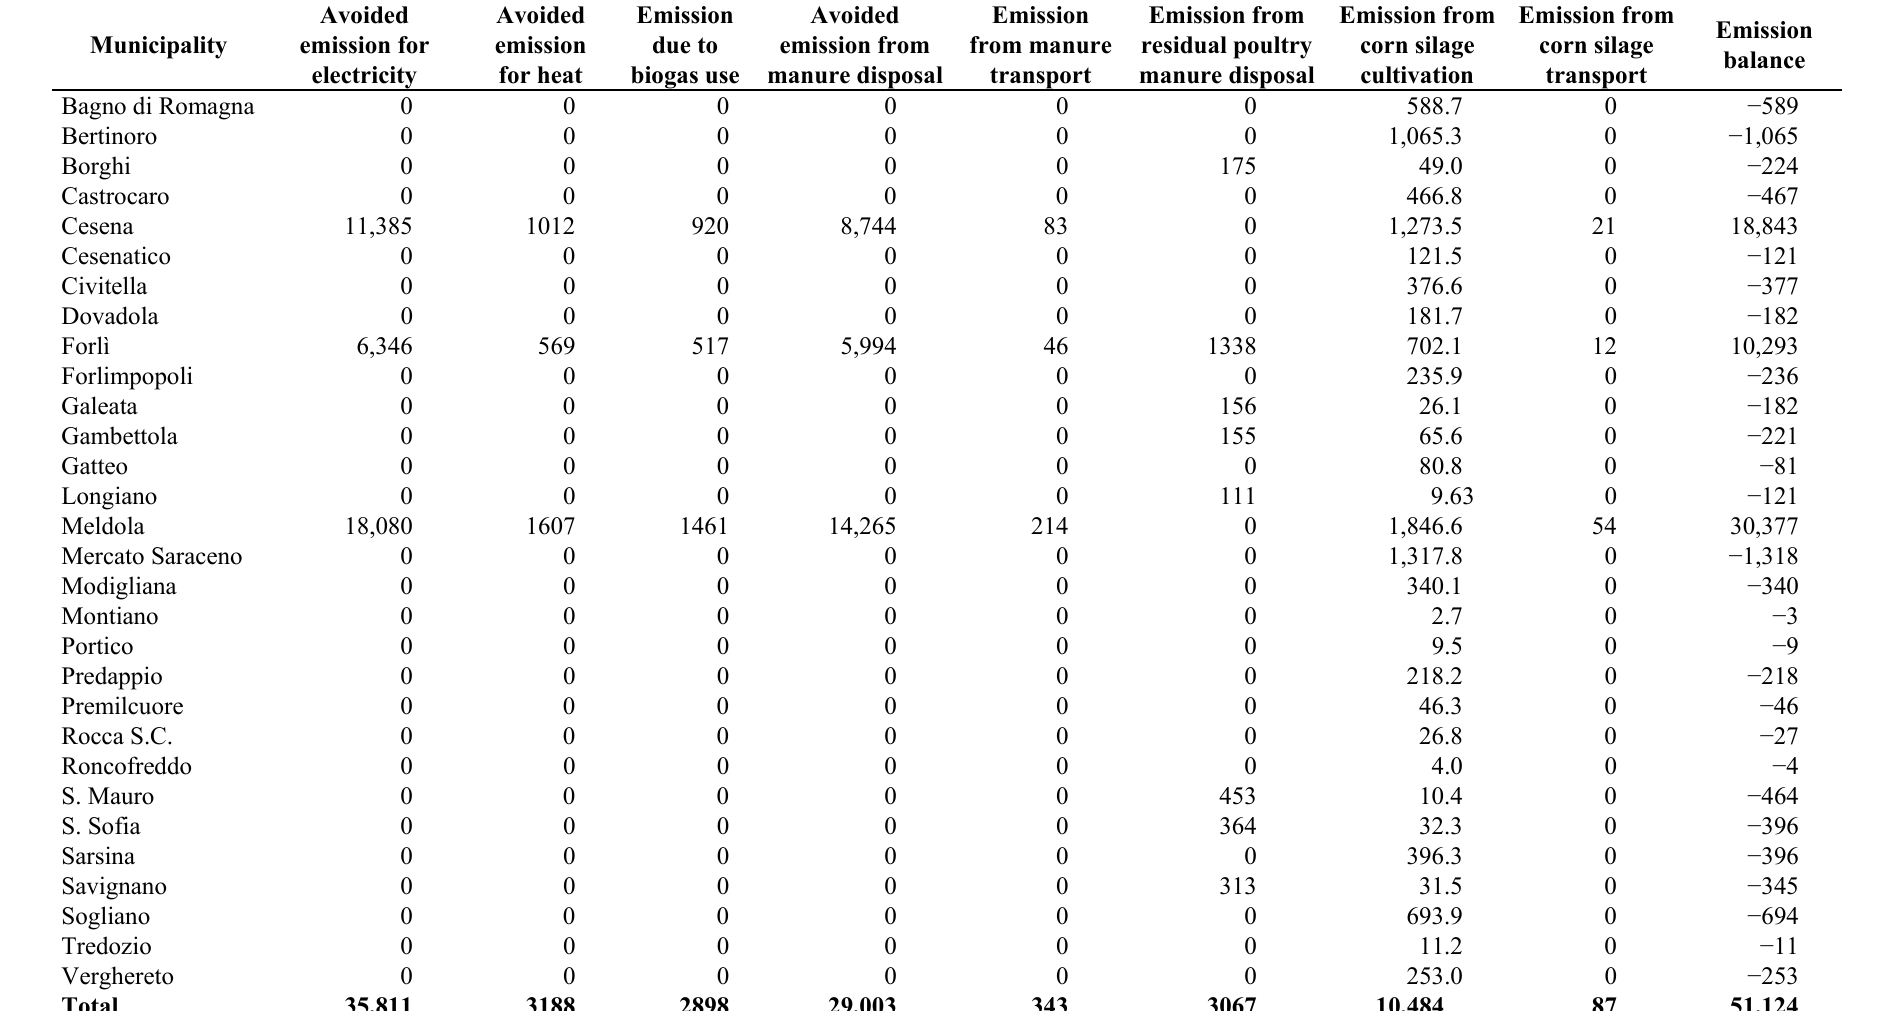
Table 9. GHG emissions (all values in Mg CO